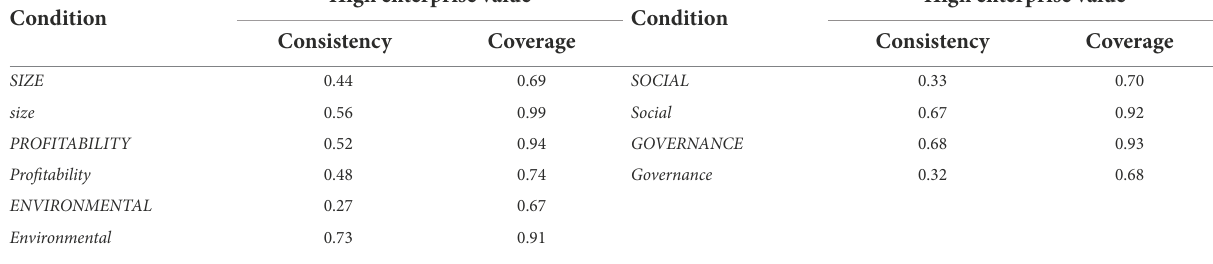
TABLE 3 Necessity analysis of single